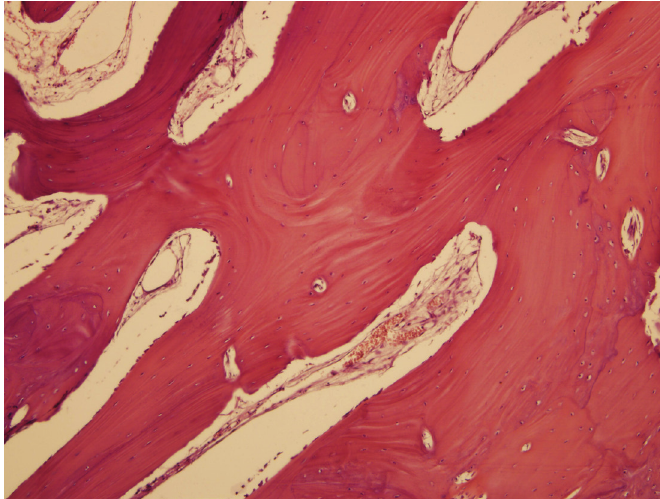
FIGURE 1 - Histologic section of the operated hemimandible of cat 23 of group 2 shows the mandible/graft interface at 20 weeks postoperative bridged by woven bone. Demineralised bone specimen. (HE -100X).